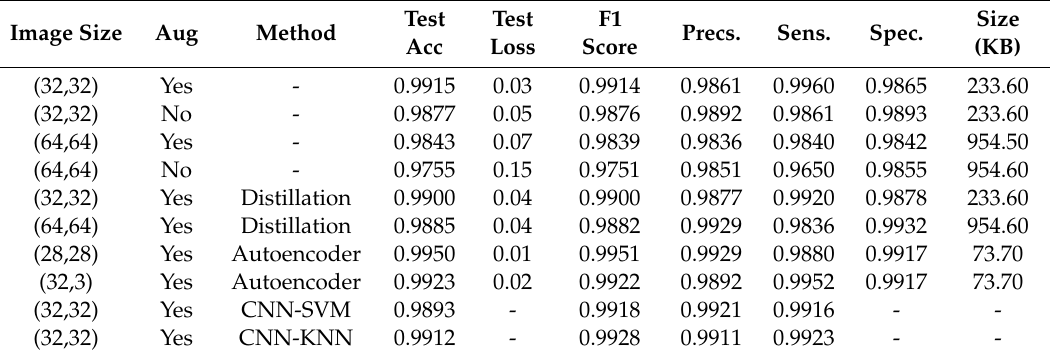
Table 5. Model performances on di ff erent